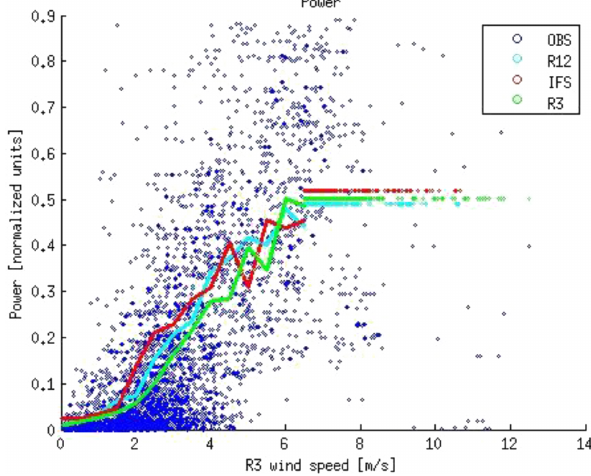
Figure 2. The power curve for R3, R12 and IFS. Blue diamonds show the pairs (wind, power) for the R3 case. R12 and IFS (wind, power) pairs are not shown for